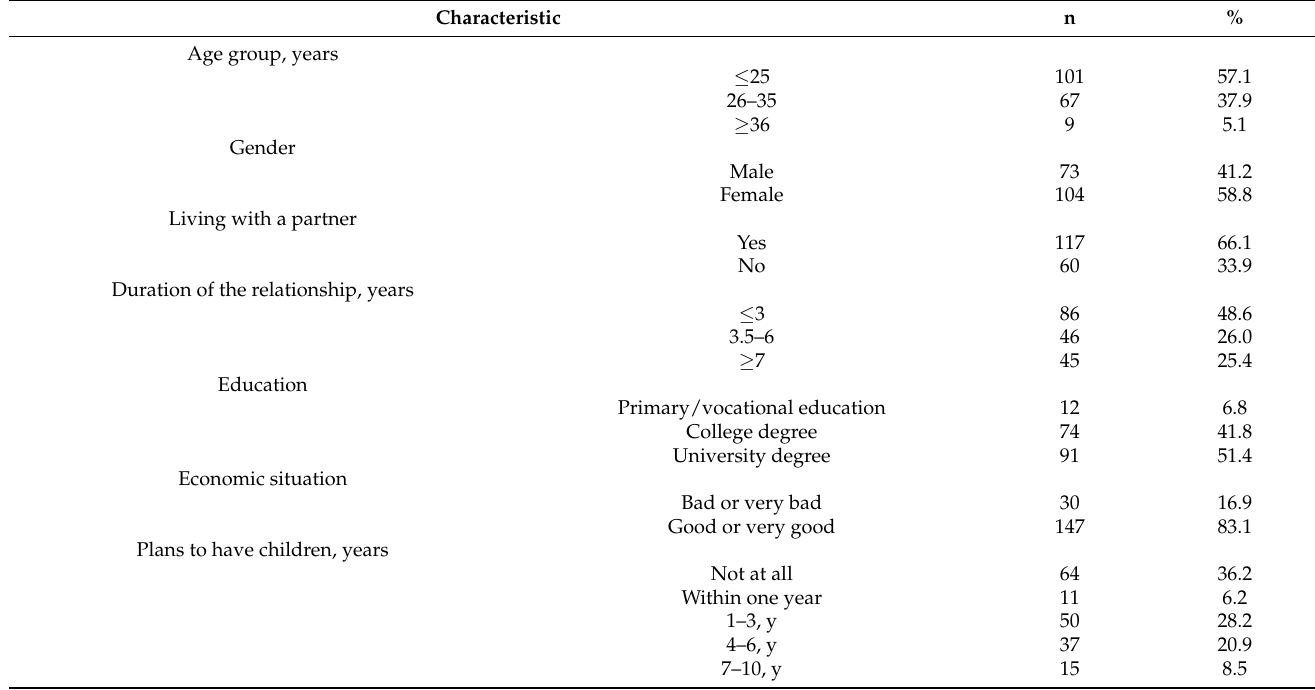
Table 1. Characteristics of the respondents (N =